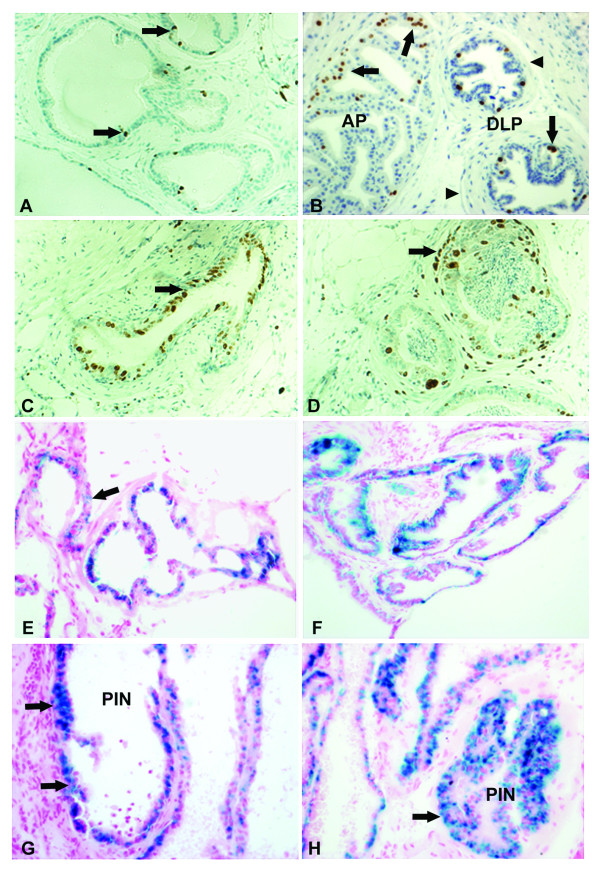
Effects of 9cRA on cell proliferation and senescence in DLP of p27 deficient mice. Fig. 2A: Cell proliferation, as determined by Ki-67 antibody in DLP of 9-month-old p27+/+ mice. Note several Ki-67-positive cells (brawn-stained, arrows) in glandular structures which are covered by a single layer of epithelial cells. The slide is counterstained by hematoxylin × 200. 2B: Ki-67 positive cells (arrows) in anterior (large left) and DLP (two right glands) of 9-month-old p27-/- mice. Note the thick connective tissue surrounding glandular structures. The slide is counterstained by hematoxylin × 200. 2C: Ki-67 positive cells in PIN of MNU-treated mice. The number of Ki-67 positive cells is higher (arrow), as compared to those in Fig. 2B. The slide is counterstained by hematoxylin × 200. 2D: Treatment of p27-/- mice with 9cRA for 6 months reduced the number of Ki-67 positive cells in PIN (arrow). Note the inflammation associated cells in PINs' lumen. The slide is counterstained by hematoxylin × 200. 2E: Senescent cells (blue stained) determined by SA-β-Gal staining in glandular and ductal structures of DLP of 9-month-old p27+/- mice. Senescent cells are also detectable among myoepithelial and stroma cells (arrows). The slide is counterstained by nuclear fast red × 200. 2F: Treatment of animals with 9cRA increased senescent cells (blue stained) in DLP and AP of a p27+/- mice. The slide is counterstained by nuclear fast red × 200. 2G: 9cRA increased senescent cells in low grade PIN (arrows) as compared to non-PIN areas of a 10-month-old p27+/- animal. The slide is counterstained by nuclear fast red × 200. 2H: 9cRA also increased senescent cells in high grade PIN as shown in the right glandular structure. The slide is counterstained by nuclear fast red × 200.